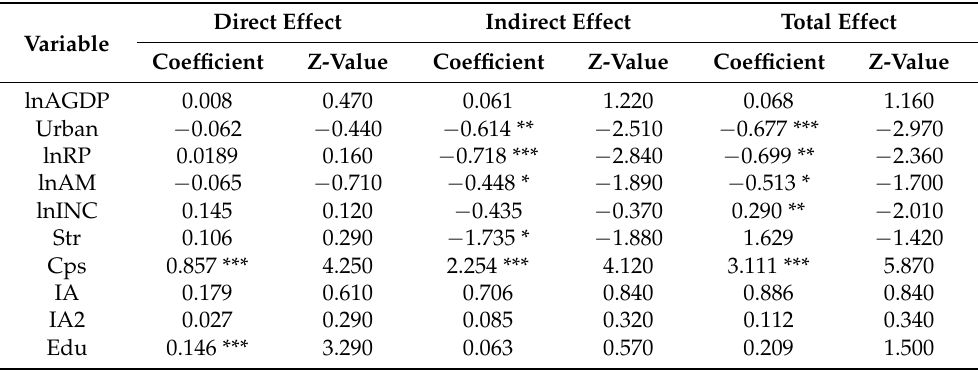
Table 11. Estimation of the direct and indirect effects of various factors on the ACESs by region (26 counties in the mountainous